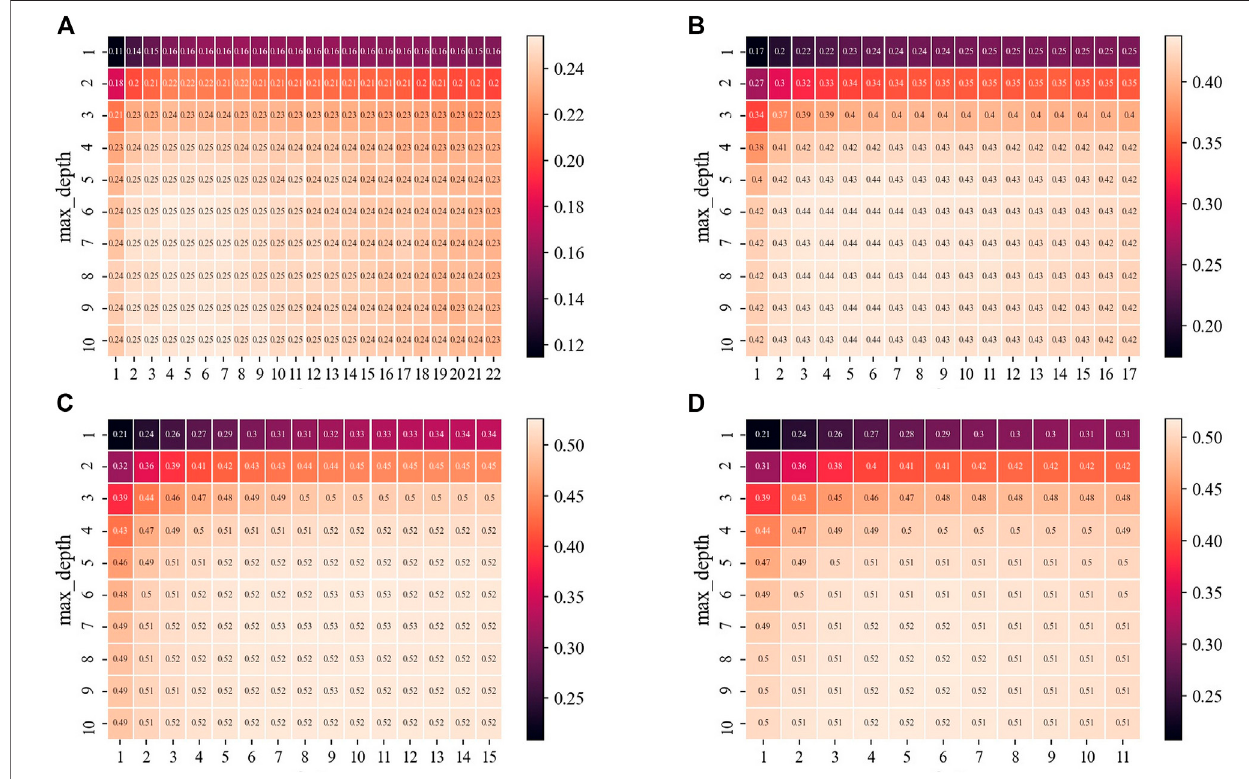
FIGURE 6 | Heatmaps are provided with R 2 of grid research and cross-validation in case of drought-affected area. (A) 2011 – 2019. (B) 2004 – 2019. (C) 1987 – 2019. (D) 1979 – 2019.